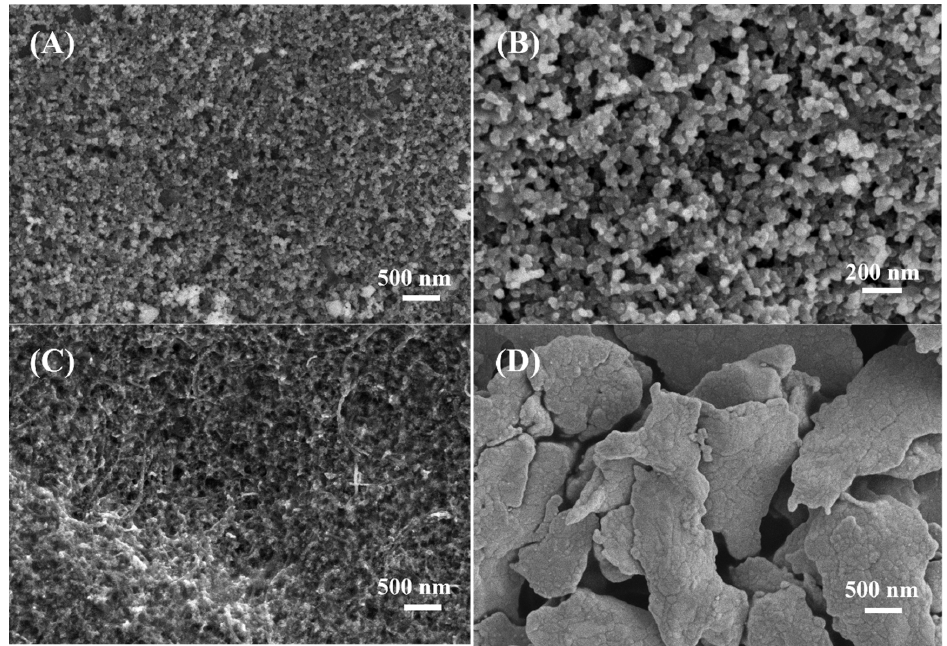
Figure 2. SEM images of ( A , B ) unmodified bare carbon electrode with different magnifications, ( C ) MWCNT-COOH modified carbon electrode and ( D ) Ag/AgCl electrode. ( C ) MWCNT-COOH modified carbon electrode and ( D ) Ag/AgCl